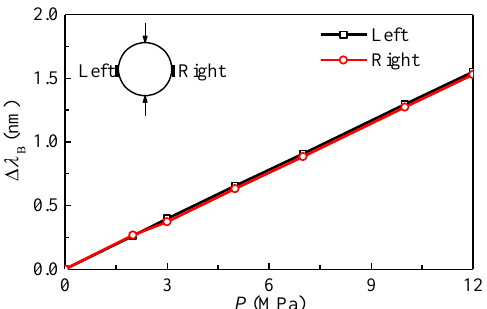
Figure 11. Variation of wavelength shifts of two FBGs bonded on the same ring with applied loads.